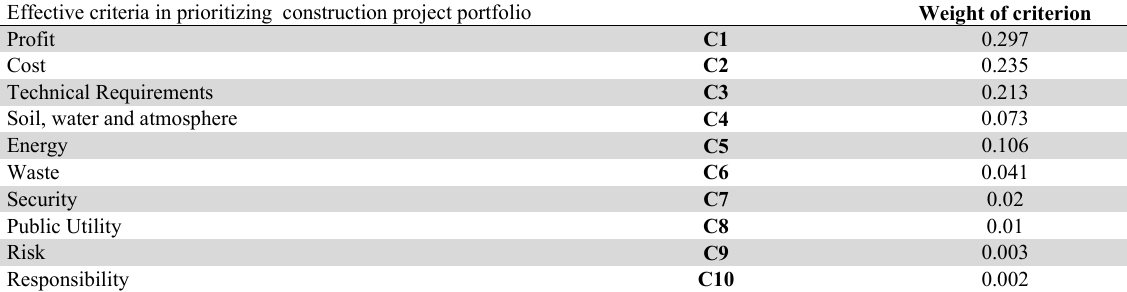
Weight of criterion derived from lexicographic method Effective criteria in prioritizing construction project portfolio